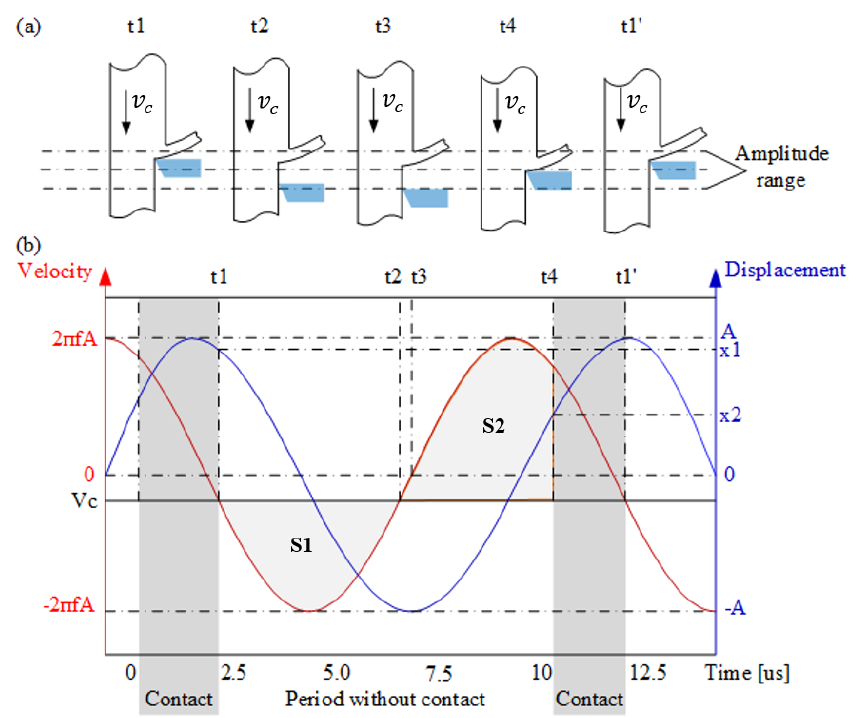
Figure 1. ( a ) Schematic diagram of the position relationship between the tool and the workpiece in UVAC. ( b ) The kinematics of